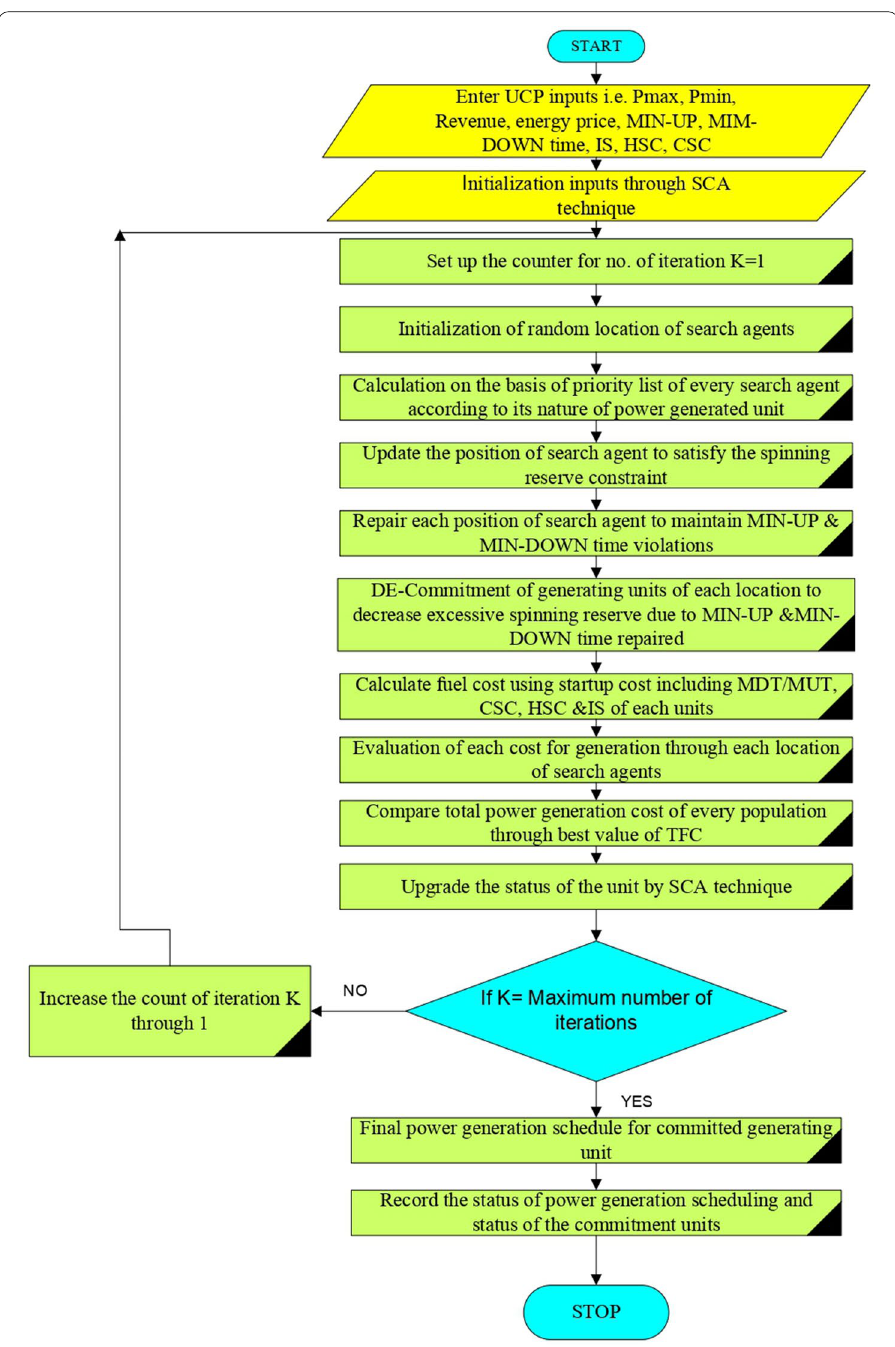
Fig. 6 Flowchart of complete procedure of commitment by SCA